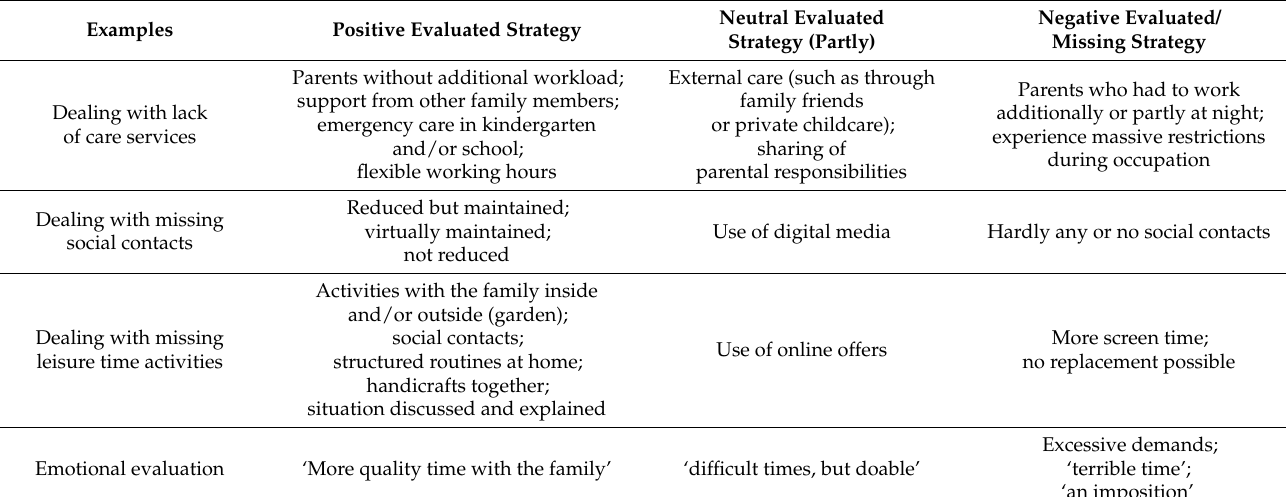
Table 1. Free-text answers regarding coping strategies; divided into